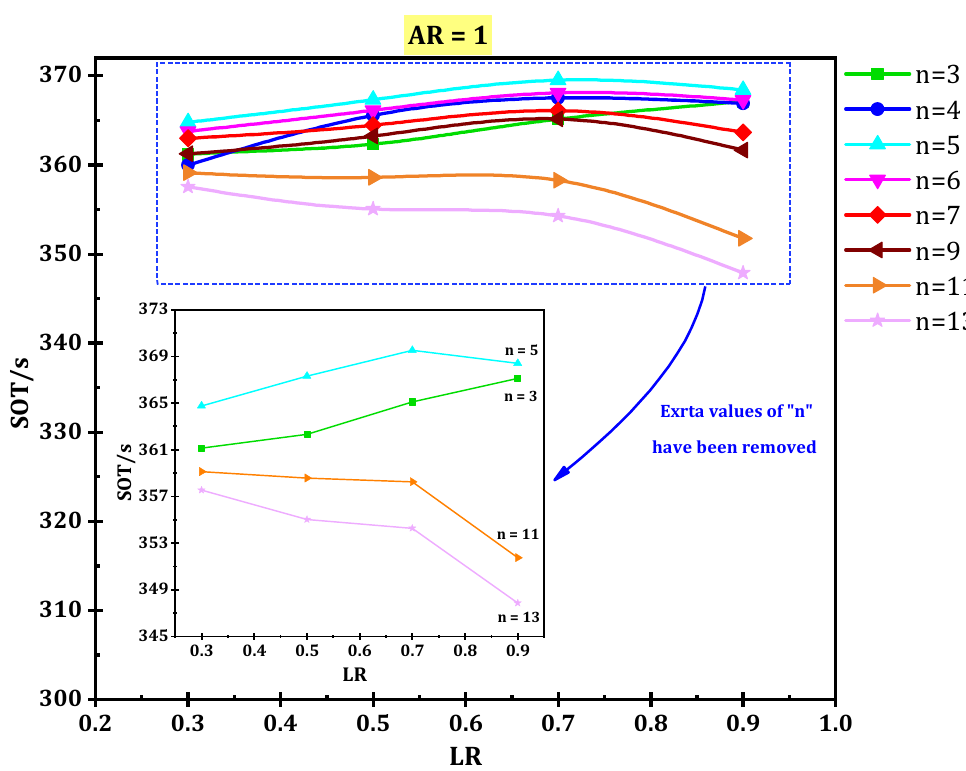
Figure 7. Effects of length ratio (LR) on SOT at different horizontal fins number (H = 10 mm ) . In Figure 8 the streamlines for the three LR values (0.3, 0.7 and 0.9) are depicted. As can be seen, at length ratio of LR = 0.7, the convection is formed in two places (between the horizontal fins and the distance between the horizontal fin tip and the line of symmetry). But at LR = 0.5 and LR = 0.9 the convection is formed only in one place. The presence of streamlines in each zone indicates that there is a liquid phase motion which implies the possibility of the natural convection heat transfer.